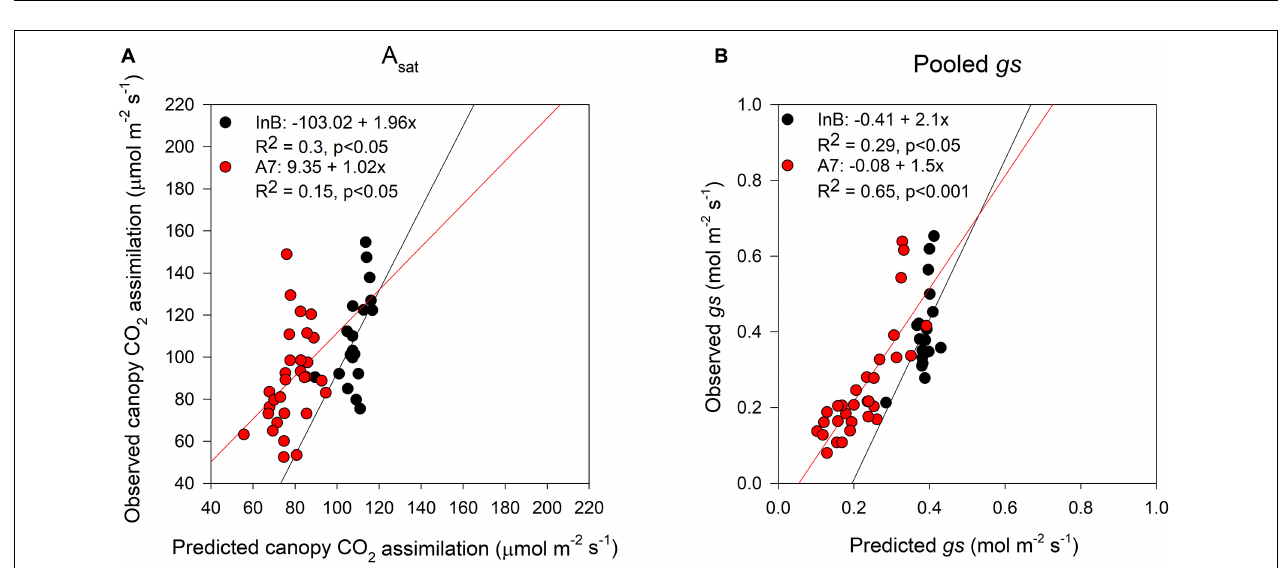
FIGURE 5 | Variable importance in projection plot of gas exchange, biochemical and biophysical traits of the models built with all the canopy layers combined. Y -axis represents the variance importance score where values > 1 represent wavelengths with greater importance for the model predictions. X -axis represents the wavelength (nm). Physiological traits are represented by different colors in each plot as indicated in the figure legends.